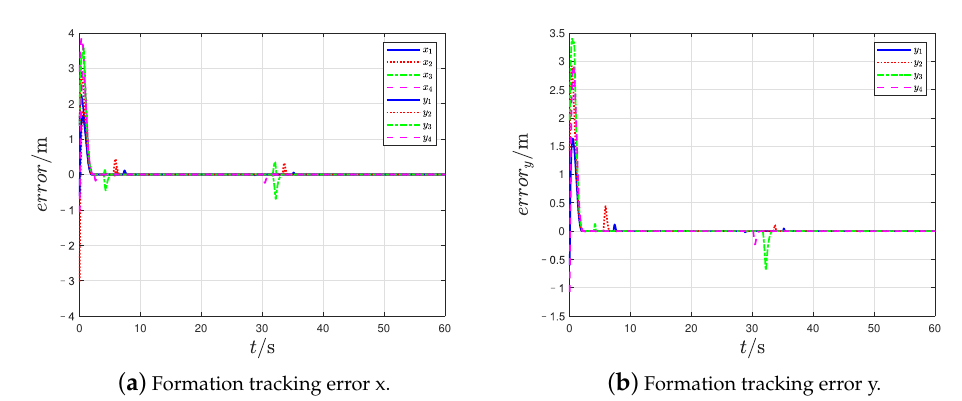
Figure 4. Observation error.